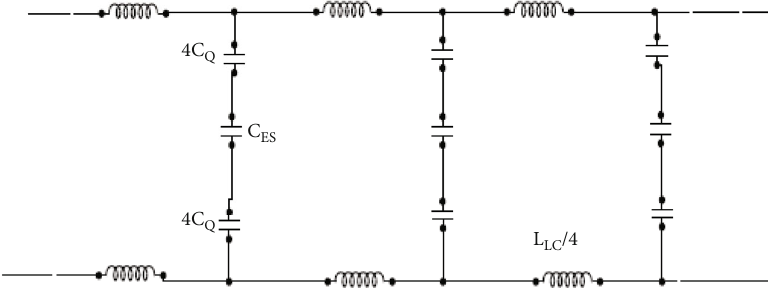
Figure 6: CNT patch antennas.